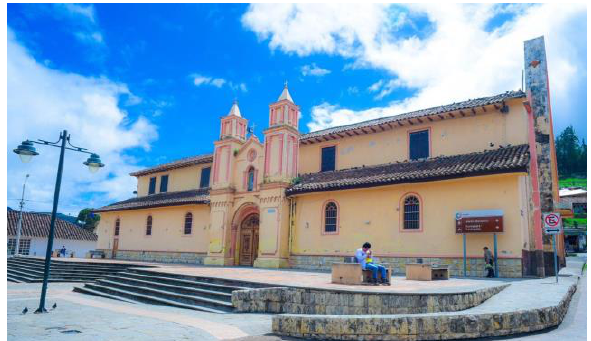
Figure 4 . San Juan Bautista’s church in Nabón